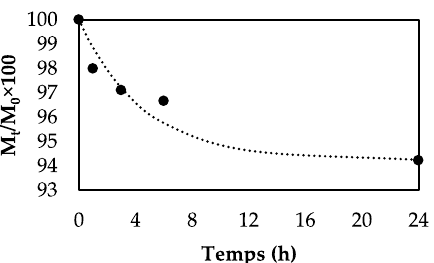
Fig. 3. Analytical simulation of the desorption kinetics of EOCa in the RC medium. ( (cid:129) ): Experimental results; ( … ): Simulation,